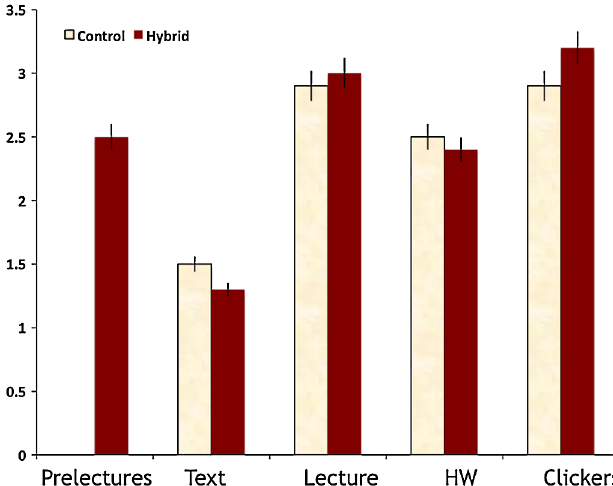
FIG. 4 (color online). Student rankings of the usefulness of the course components for both the control and the hybrid-MLM groups. We used MasteringPhysics online